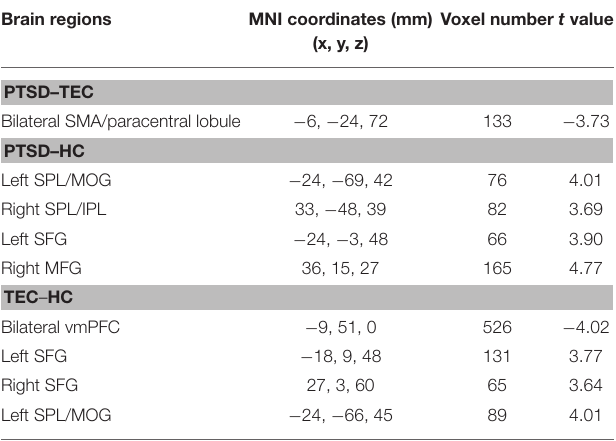
TABLE 4 | Comparison of the effective connectivity to the left amygdala. Brain regions